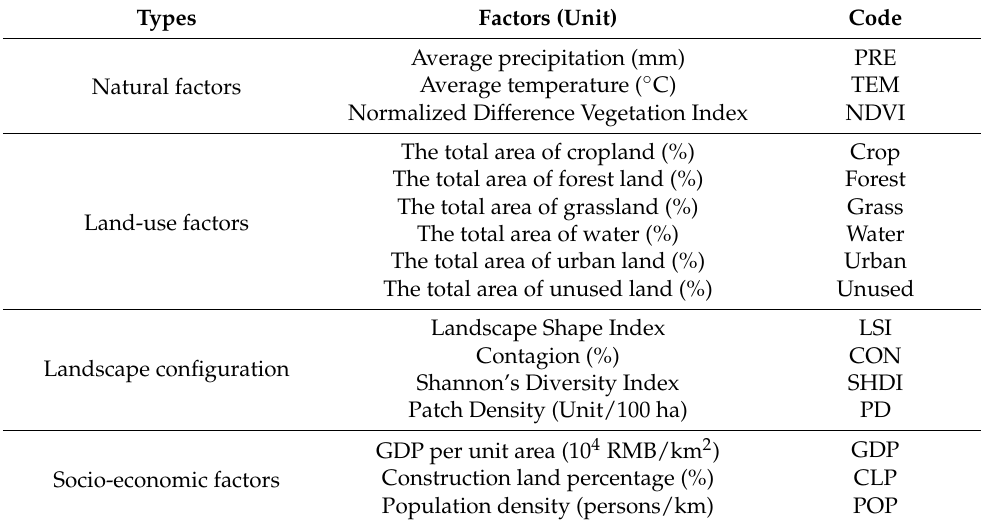
Table 3. Description of potential driving factors investigated in this study. Types Factors (Unit) Code Average precipitation (mm) PRE Average temperature ( ◦ C) TEM Natural factors Normalized Difference Vegetation Index NDVI The total area of cropland (%) Crop The total area of forest land (%) Forest The total area of grassland (%) Grass Land-use factors The total area of water (%) Water The total area of urban land (%) Urban The total area of unused land (%) Unused Landscape Shape Index LSI Contagion (%) CON Landscape configuration Shannon’s Diversity Index SHDI Patch Density (Unit/100 ha) PD GDP per unit area (10 4 RMB/km 2 ) GDP Construction land percentage (%) CLP Socio-economic factors Population density (persons/km)